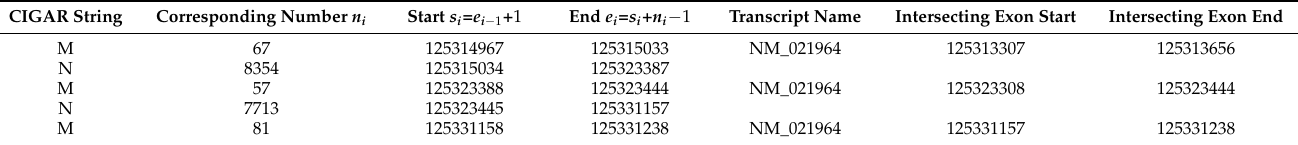
Table 3. Process of extracting exons and introns from the CIGAR value of chimeric alignments.